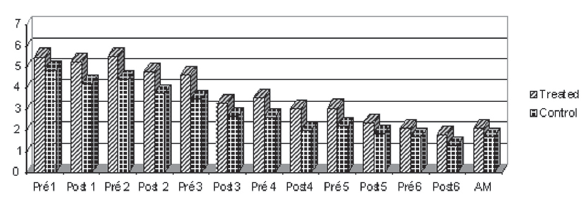
FIGURE 1- Mean pain for treated and control groups with tactile stimulus